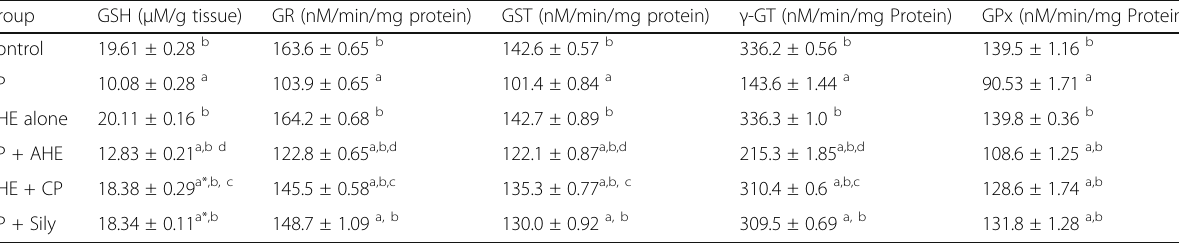
Table 4 Effect of cisplatin (CP) and different treatments of AHE on phase II antioxidant enzymes Group